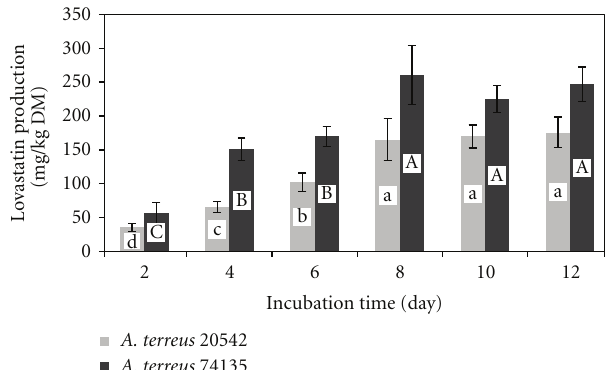
Figure 11: Lovastatin production by A. terreus in optimum condition at di ff erent time of incubation ( P < 0 . 01). (a, b, c, and d) indicate di ff erences among means between samples for A. terreus ATCC 20542. (A, B, and C) indicate di ff erences among means between samples for A. terreus ATCC